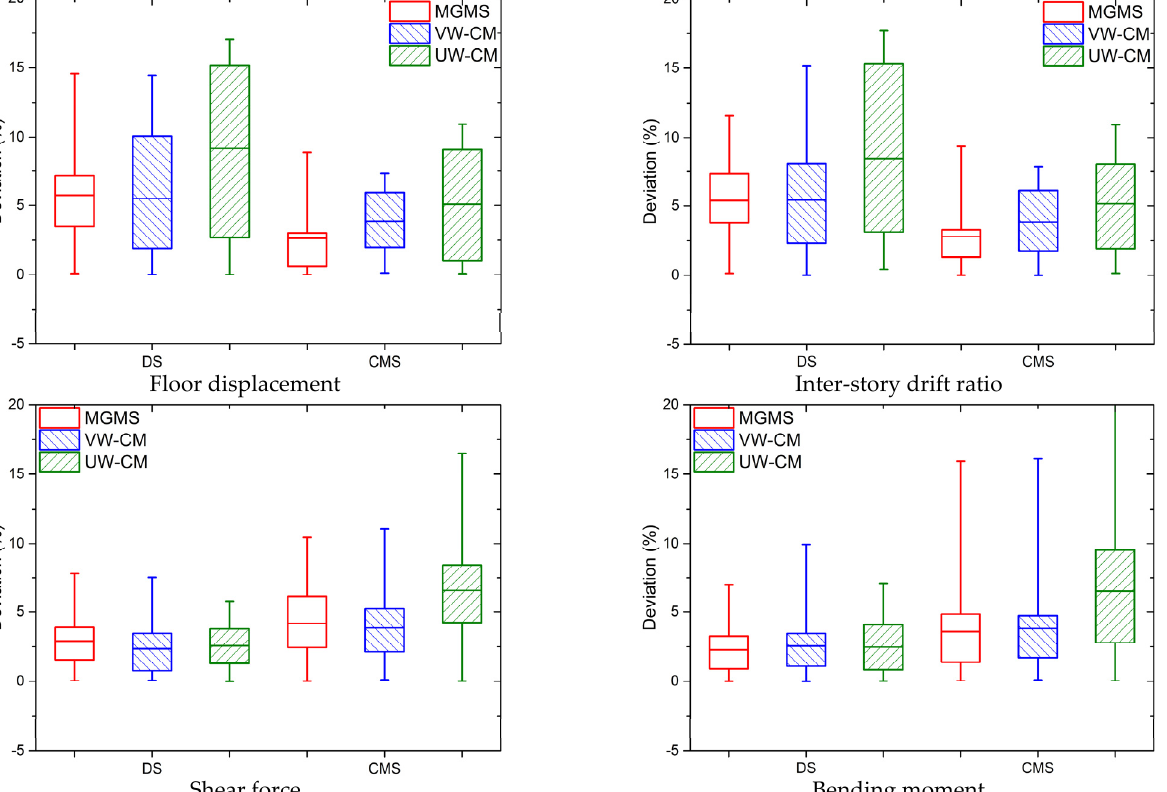
Figure 8. Deviations between the seismic demands from different IGM selection procedures and benchmark demands.